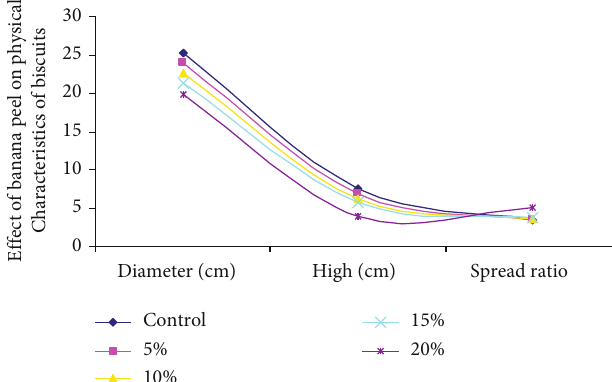
Figure 4: Physical characteristics of di ff erent blends of